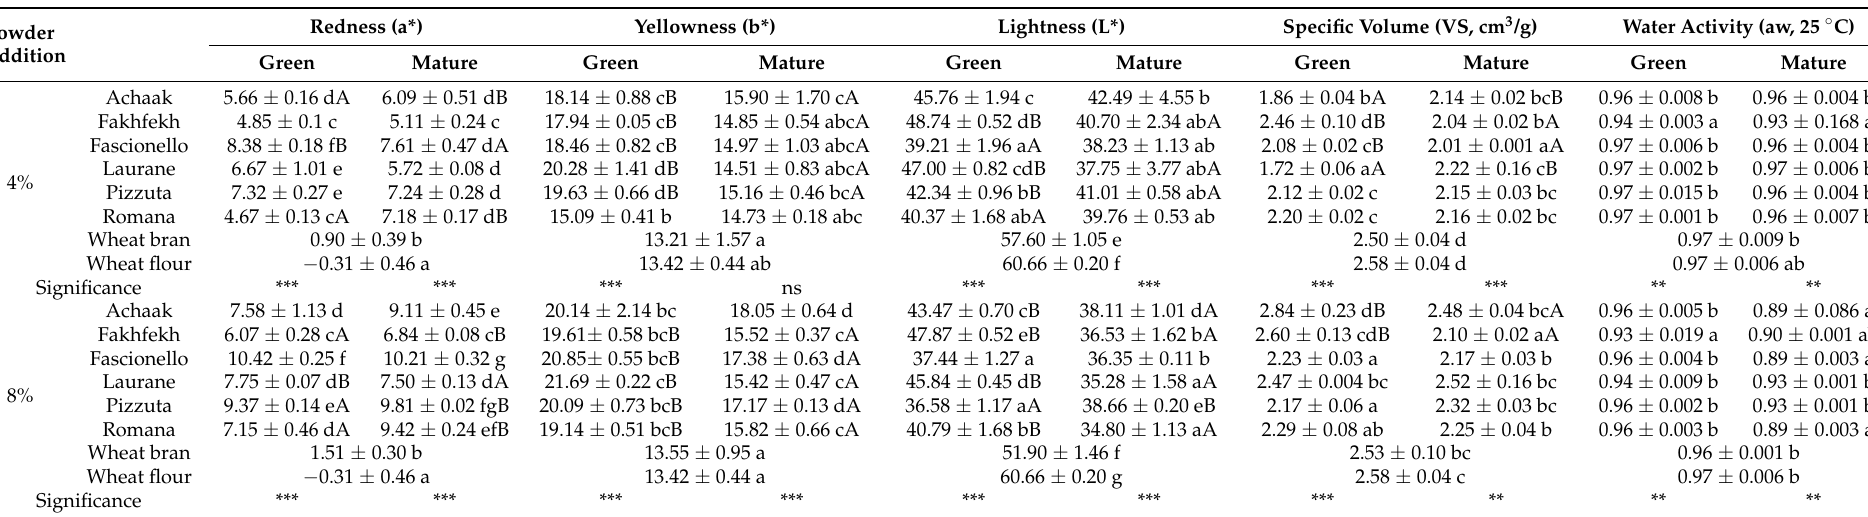
Table 5. Values of crumb colour, specific volume, and water activity evaluated on the control breads and breads with 4% and 8% of AH powders and wheat bran, and results of variance analysis with Duncan’s test ( p < 0.05) performed between the products and the two harvesting times (green and